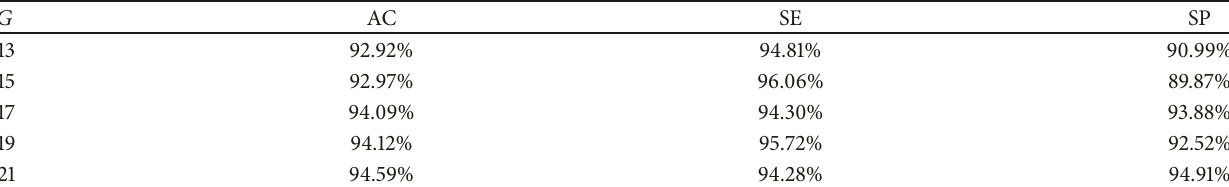
Table 5: Results of majority voting under different parameters.